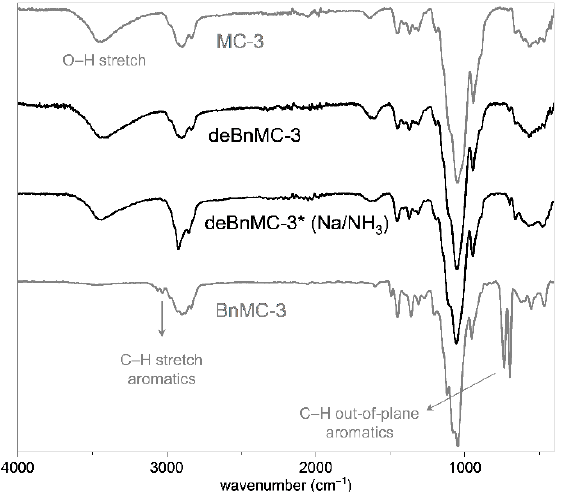
Figure 8. The ATR-IR spectra of deBnMC-3 (Method 2c, Table 1) and deBnMC-3* (Na/NH 3 , Table 1, Method-3). Spectra of MC-3 and BnMC-3 are shown for comparison. The small deviation of the peak shape of deBnMC-3* (Na/NH 3 ) in the C-H region at 2921 cm –1 might be due to impurity.